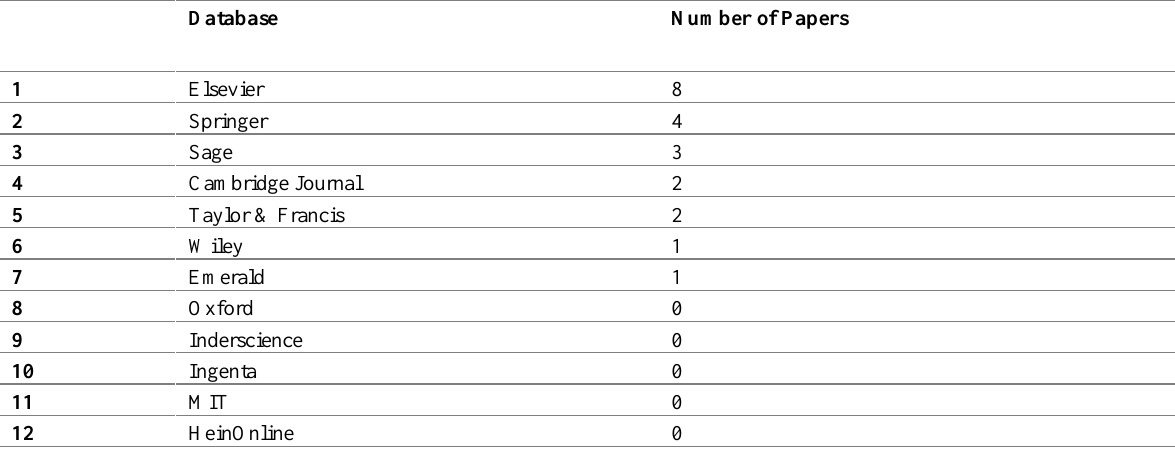
Table 2: Number of Papers downloaded in